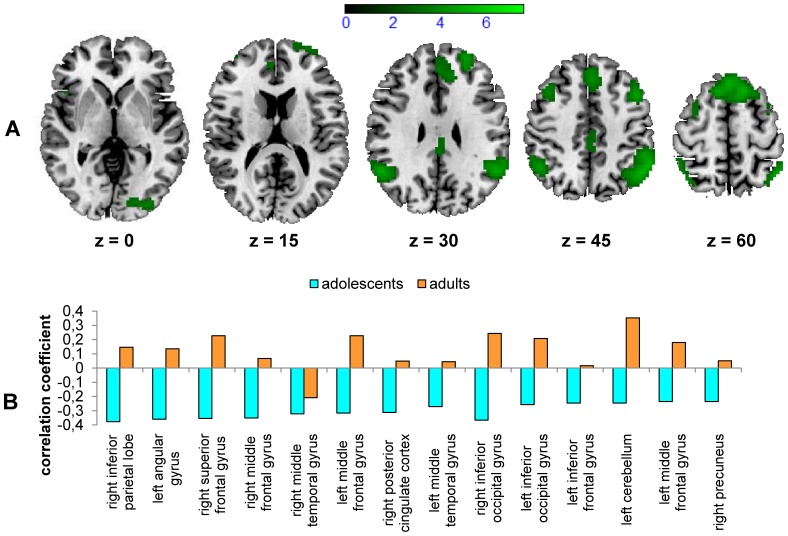
Brain response during correct post-error/post-missing trials.Note that only 181 adolescents and 22 adults which made at least three mistakes were considered for this analysis. A) Regions of the brain during post-error/post-missing trials that show a significant negative correlation with overall ER (threshold T = 2.77, p<0.05, FDR-corrected, in 25 contiguous voxels) in adolescents. B) Correlation coefficients for the correlation between brain response during post-error/post-missing trials and overall ER for adolescents (blue) and adults (orange) in the peak voxels (sorted by t-values, please see also Table S4). The correlations only reached significance in adolescents.